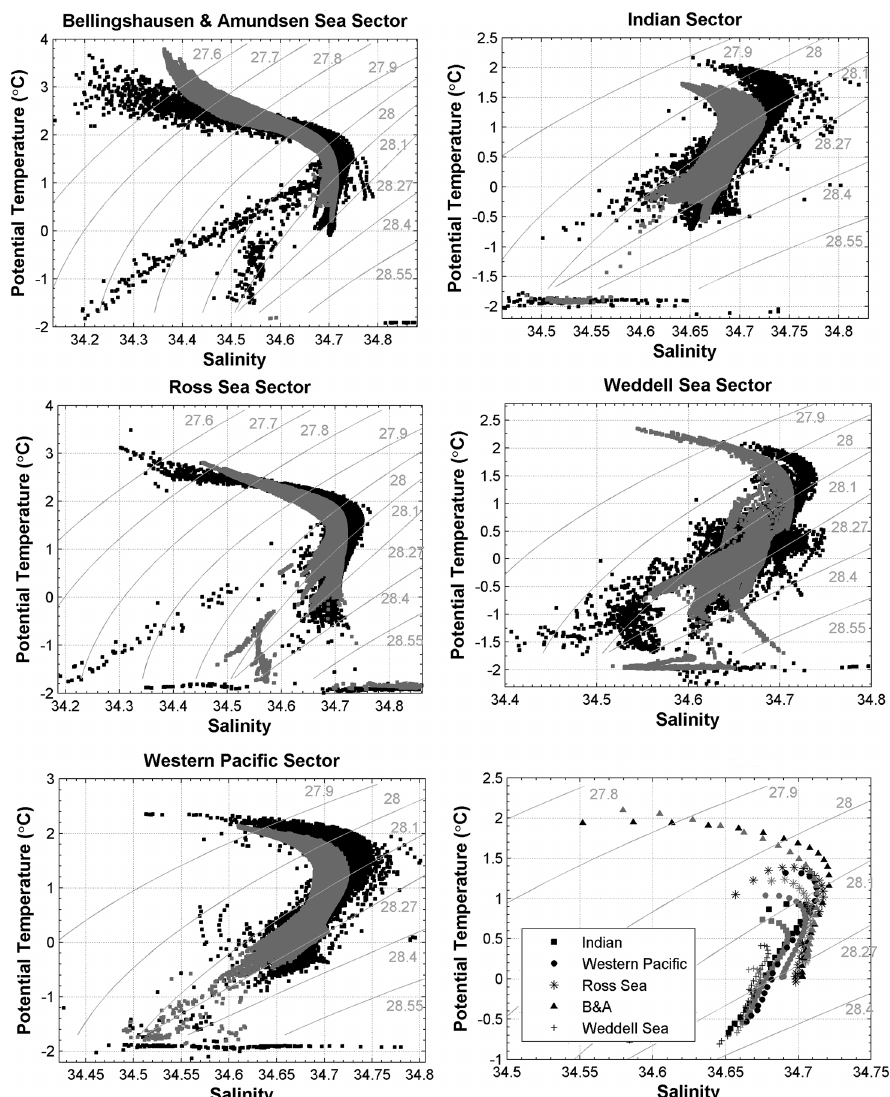
Figure 2. Twenty-year (1992–2011) average (summer only) θ –S diagrams for the water column deeper than 500m within each Southern Ocean sector, as defined in Fig. 1. The observational data set was averaged on the reanalysis grid and then averaged with respect to time (1992–2011). Solid lines represent the neutral density isopycnals ( γ n ;kgm − 3 ) . Gray (black) dots refer to the ECCO2 (observation) data. The bottom right panel includes the areal average of all Southern Ocean sectors that are distinguished by the marker, as indicated by the